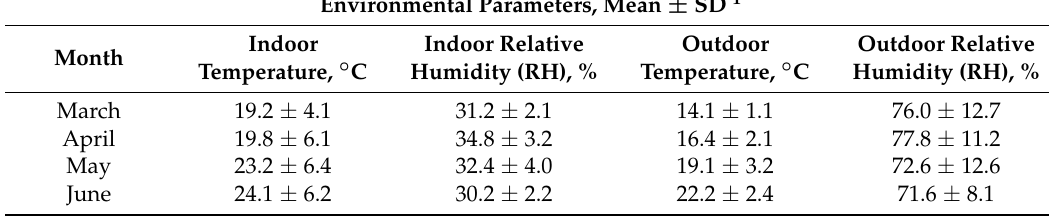
Table 1. Descriptive statistics of indoor air quality (IAQ) environmental conditions in office building by month during sample